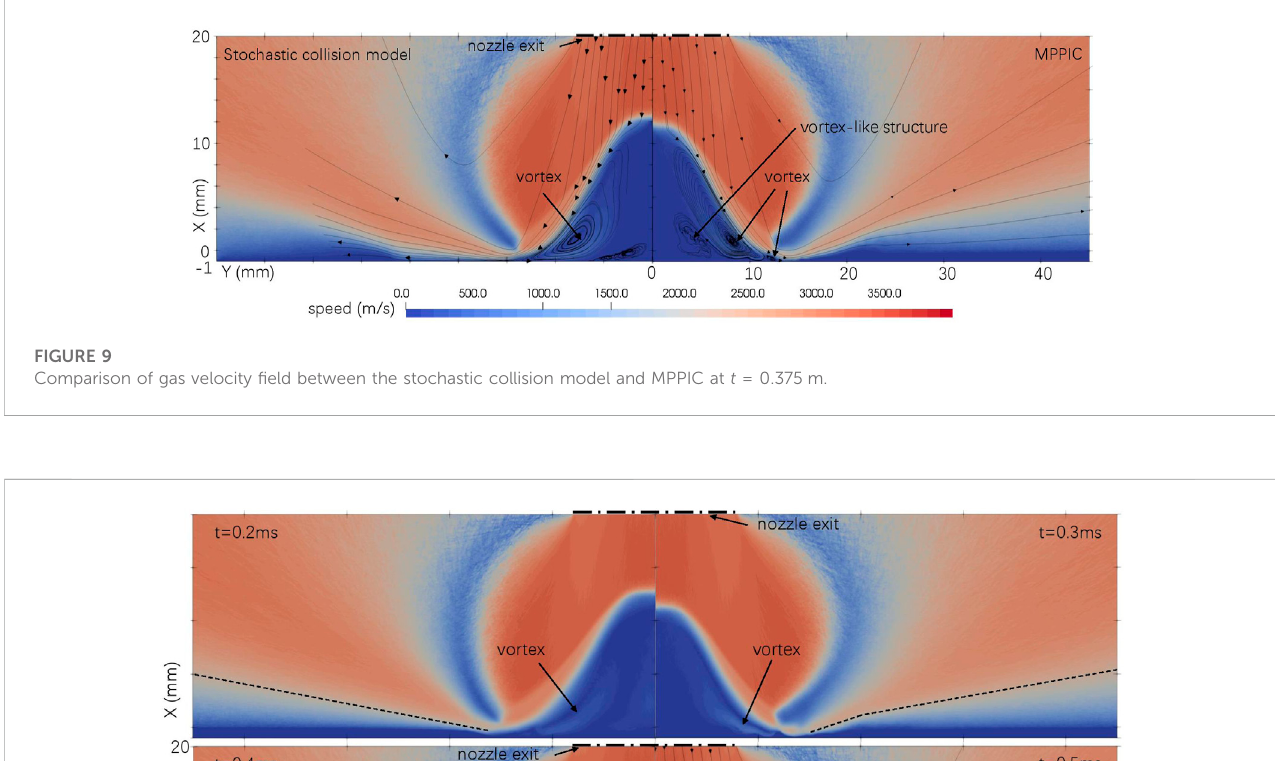
movement of the normal shock wave can also be found in the pressure and temperature distribution of Figure 14. Furthermore, the pressure and temperature distribution downstream of the normal shock wave